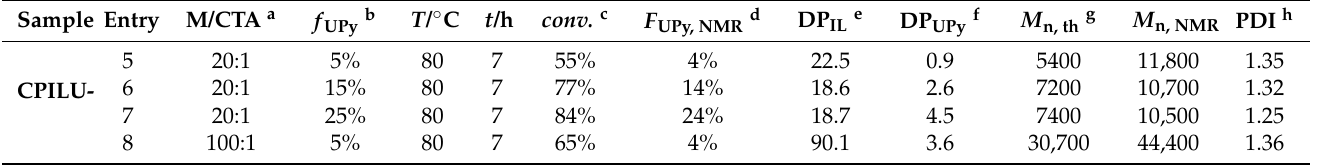
Table 2. Data from RAFT copolymerizations of ILA with UPyA and the resulting copolymer CPILU-y